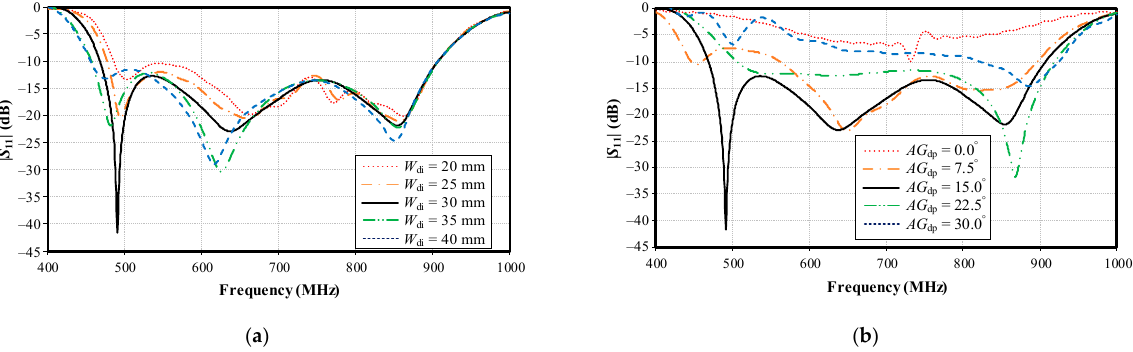
Figure 12. Simulated impedance bandwidth (| S 11 | ≤ − 10 dB) under variable parameters: ( a ) width of folded bowtie radiator ( W di ), ( b ) angle of the folded bowtie radiator ( AG dp ).